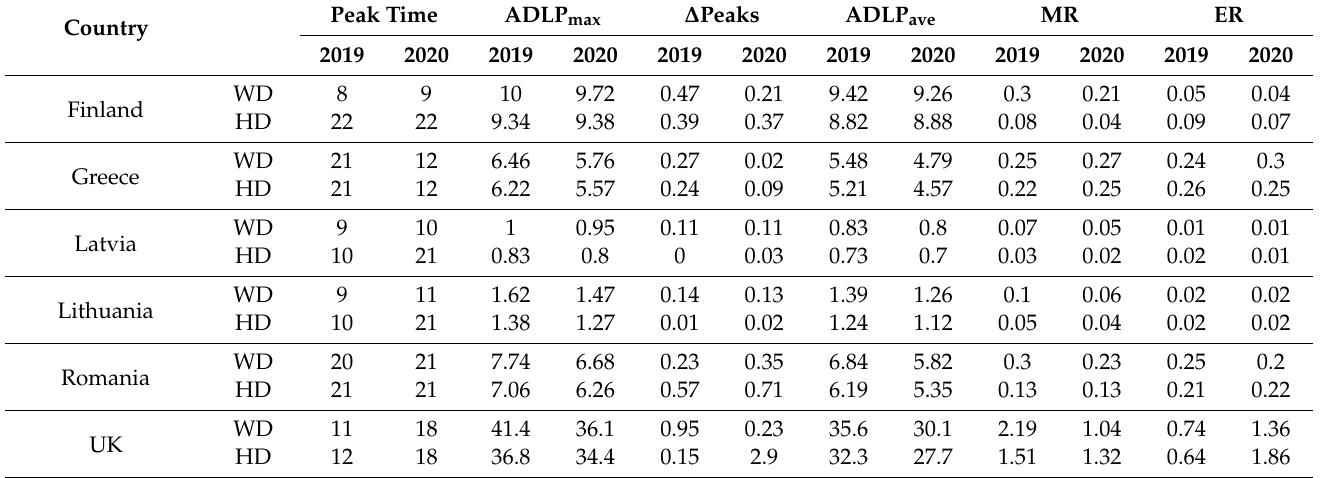
Table A3. Generation mix across Europe, April 2019–2020 (in blue the EU countries).